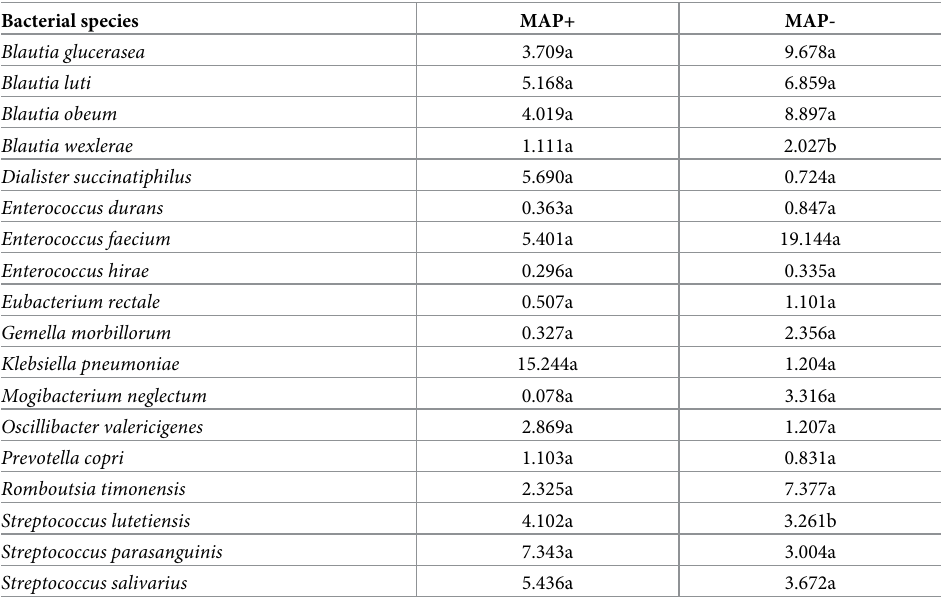
Figures with different letters are significantly different (p < 0.05); MAP+: Positive for Mycobacterium avium subsp. partuberculosis; MAP-: Negative for Mycobacterium avium subsp.